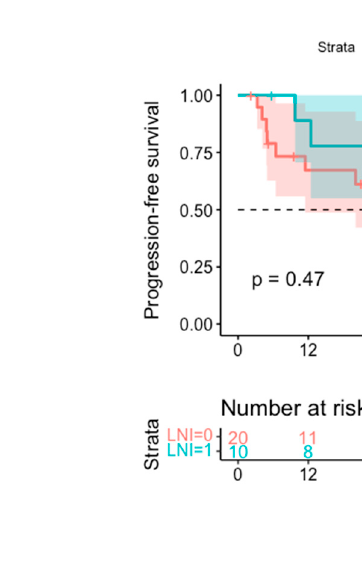
Figure 6. ( a ) OS and ( b ) PFS for SLNB negative patients with LNI (LNI = 1) and without LNI (LNI = 0).